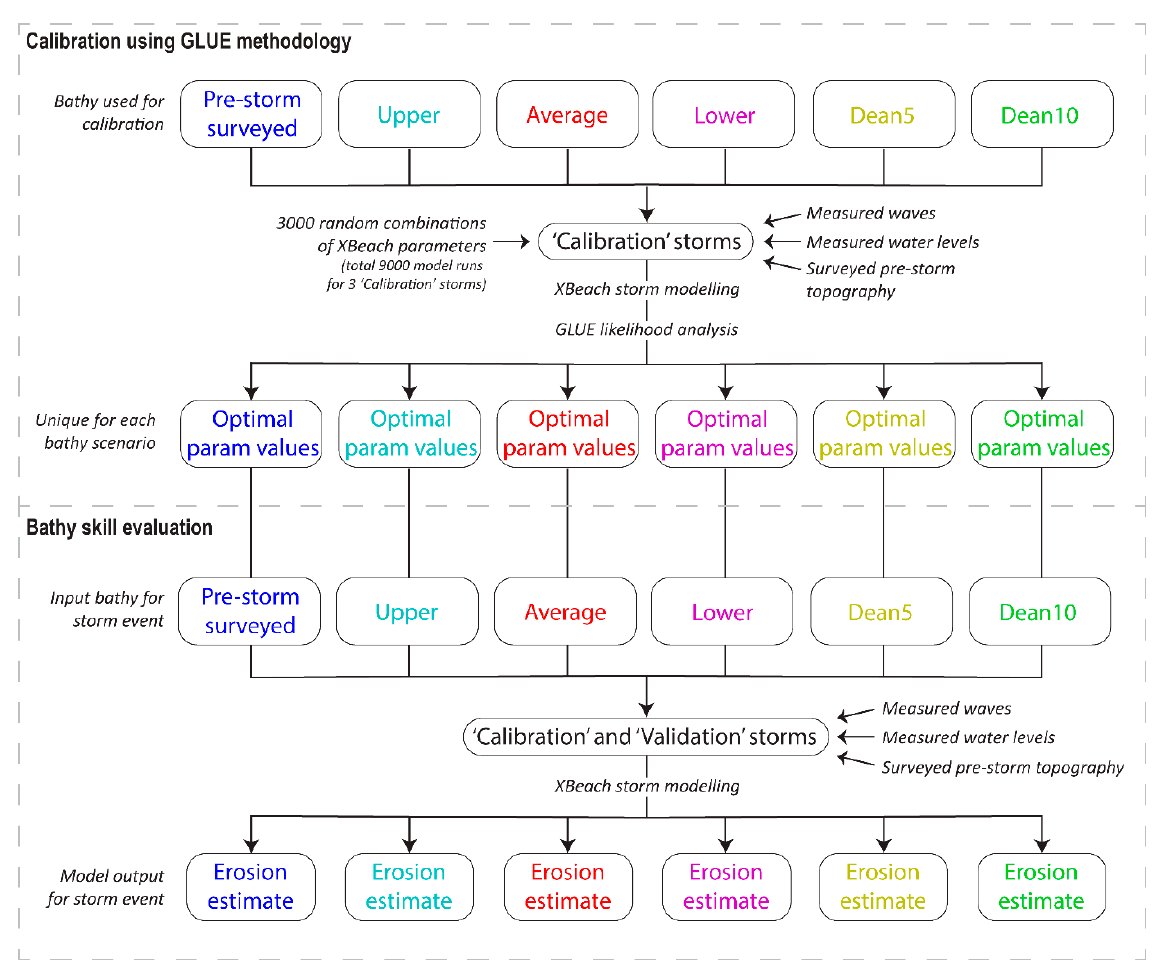
Figure 5. Flowchart visualizing the modelling workflow used to obtain erosion estimates for the six bathymetries used in this study. Six different calibrations of the XBeach model were carried out using each of the six bathymetries as the initial bottom boundary condition. This resulted in a set of XBeach parameter values that optimize model performance for each bathymetry. Erosion forecasts were then carried out using the six unique XBeach calibrations together with their associated bathymetry as the initial bottom boundary condition to evaluate predictive skill.